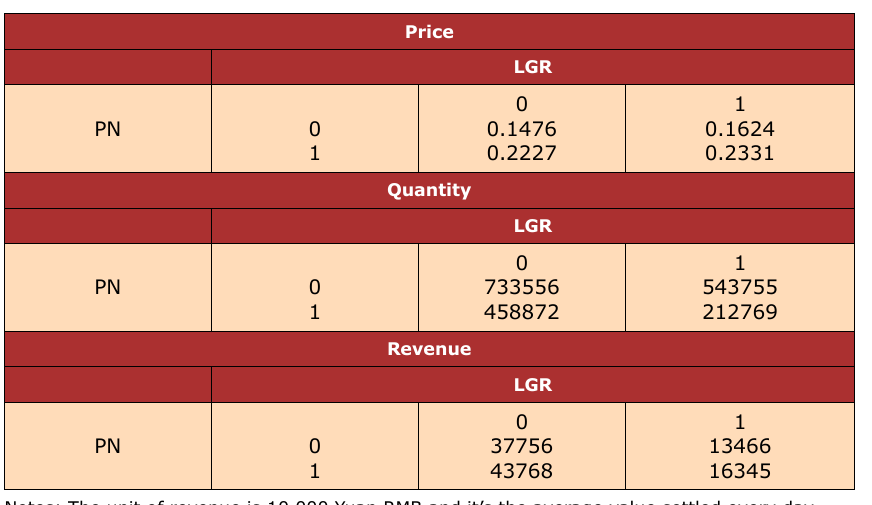
Table 4. Collusion estimation: Details on price, quantity and